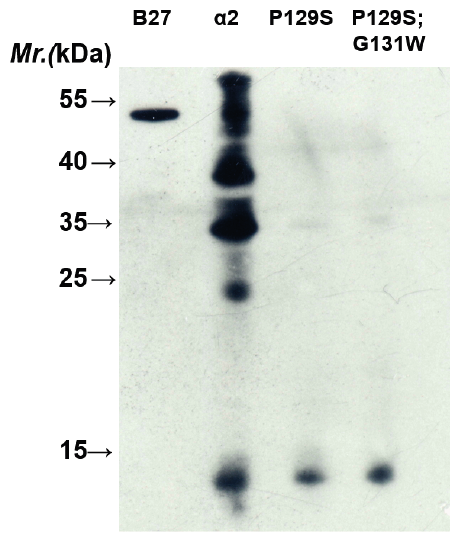
Figure 4. Double replacements of Pro-129 and Gly-131 with Ser and Trp, respectively, on the α 2 domain do not affect the BH2-binding. An aliquot (20 µg) of each crude protein extracted from E. coli bacteria that have overexpressed the indicated mutant α 2 domain of HLA-B27 HC was separated by SDS-PAGE (15%) and analyzed by western blotting using BH2 monoclonal